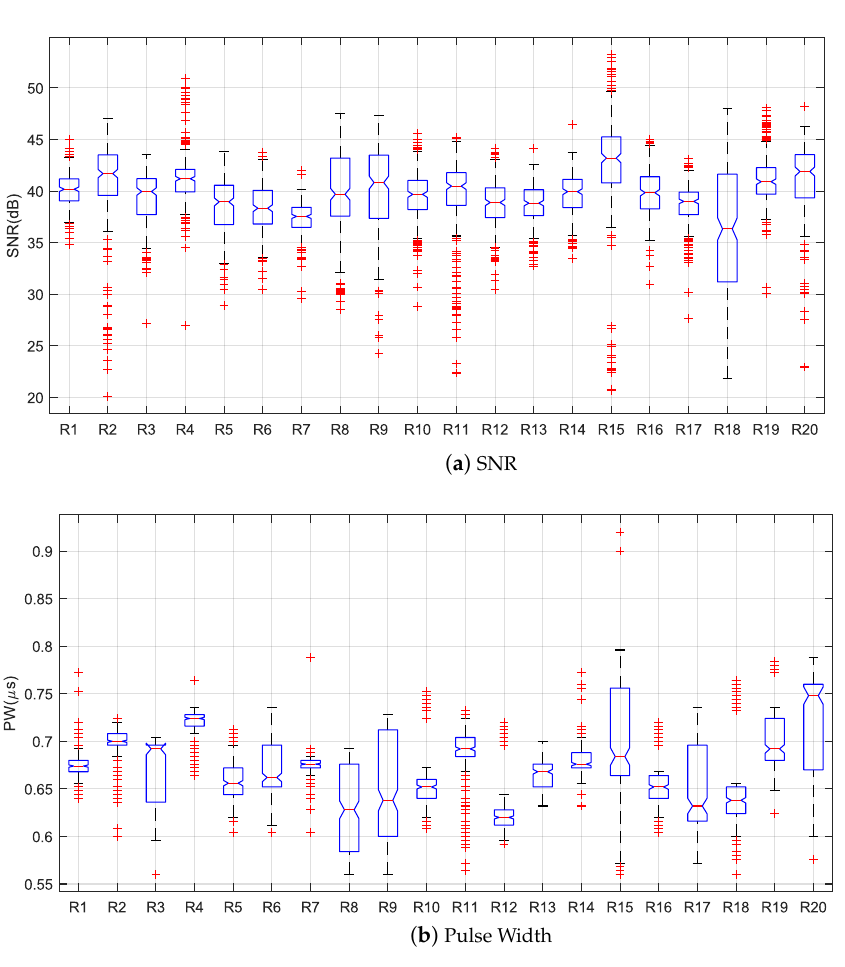
Figure 8. SNR and pulse width distribution of real-world signals of the 20 radars in Dataset